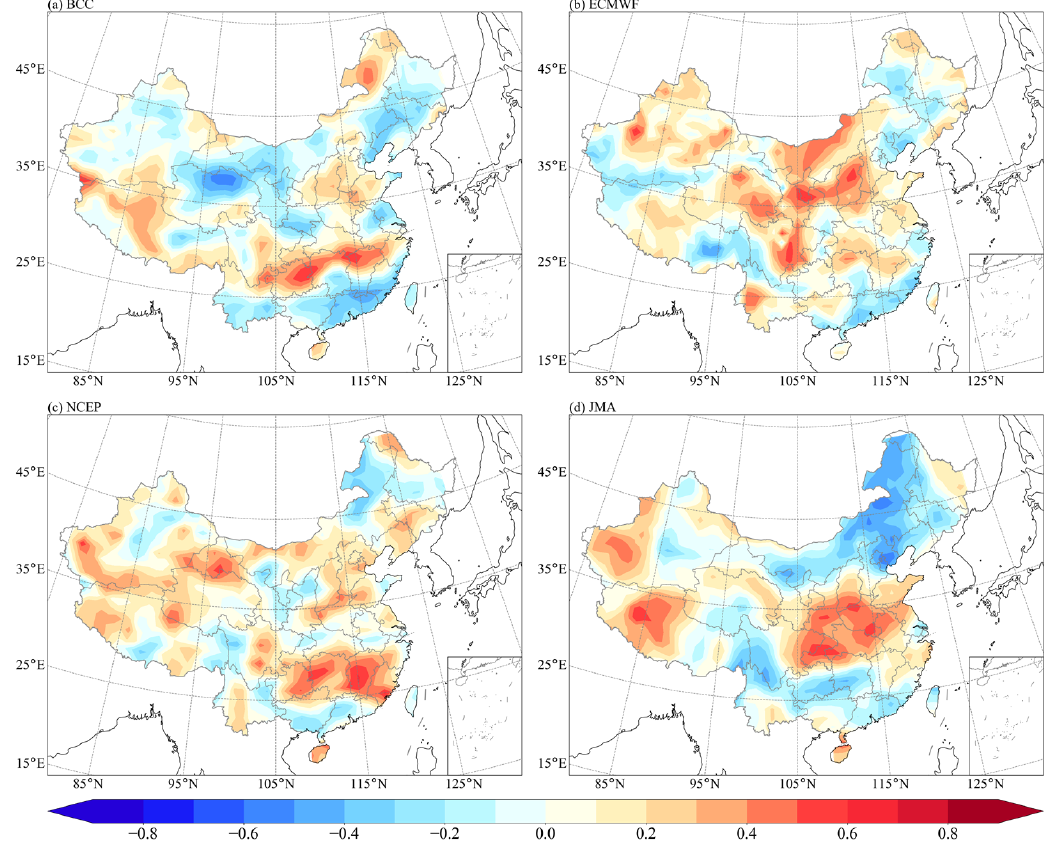
Figure 3. The time correlation coefficients between different models and observations ( a ) BCC, ( b ) ECMWF, ( c ) NCEP, and ( d ) JMA.